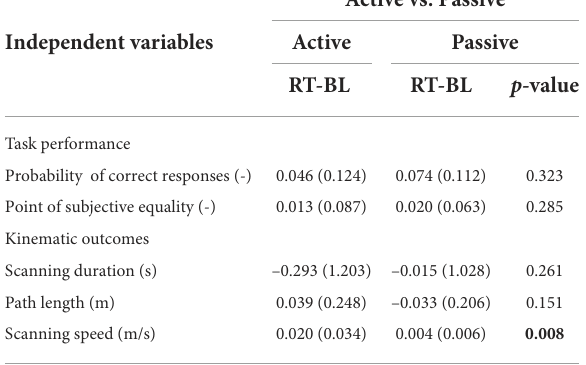
TABLE 4 Overview of results comparing the pre-post changes from baseline (BL) to retention (RT) in active vs. passive conditions.